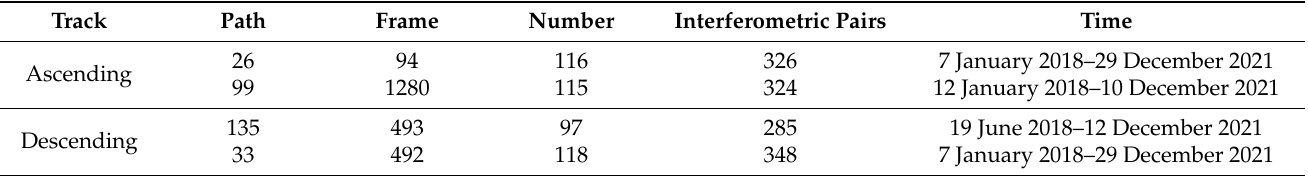
Table 1. Sentinel-1 SAR images used in this study.